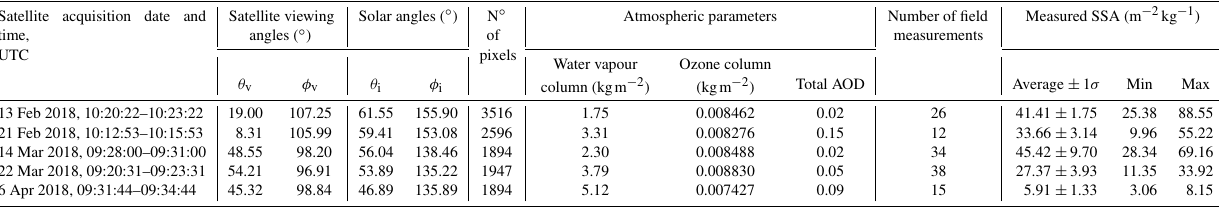
Table 3. Summary of the Sentinel-3A OLCI satellite acquisitions and the field measurements obtained for clear-sky conditions during the 2017/18 winter season. For each date the start and end times of the acquisition are indicated. The viewing and solar angles shown here were averaged across the scene. The average measured SSA across the transect is indicated with ± 1 σ representing the spatial variability in the SSA across the site.